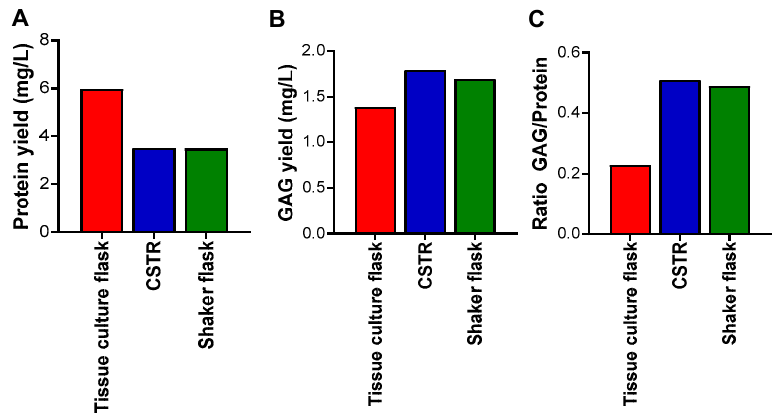
Figure 3. Yield of ( A ) protein; ( B ) glycosaminoglycan (GAG); and ( C ) the ratio of GAG to protein from HEK-293 cells expressing serglycin cultured in different bioreactors over three days and purified by anion exchange chromatography. Protein concentration was measured by Coomassie protein assay and GAG concentration was measured by Dimethylmethylene Blue (DMMB) assay. The effect of bioreactors on serglycin production and glycosaminoglycan decoration was also explored. There was no difference on the level of serglycin produced by cells in each of the bioreactors (Figure 4A). Tissue culture flasks and the CSTR produced the same level of heparin/heparan sulfate chains as detected by the presence of the HS stub structure that is demonstrated following heparinase III (HepIII) digestion and recognized by the monoclonal antibody 3G10 (Figure 4B). In contrast, the shaker flasks significantly reduced ( p < 0.05) the level of heparin/heparan sulfate chains (Figure 4B). Unlike heparin/heparan sulfate, which has one stub structure, chondroitin sulfate (CS) has multiple stub structures, following chondroitinase (C’ase) ABC digestion, including the 4- or 6-sulfated stub that can be detected with monoclonal antibodies 2B6 or 3B3, respectively (Figure 4C). While the level of chondroitin sulfate chains with 6-sulfated stub structures was not altered in any of the bioreactors analyzed, the level of 4-sulfated stub structures was significantly reduced in the shaker flasks compared to the tissue culture flask and CSTR (Figure 4C).